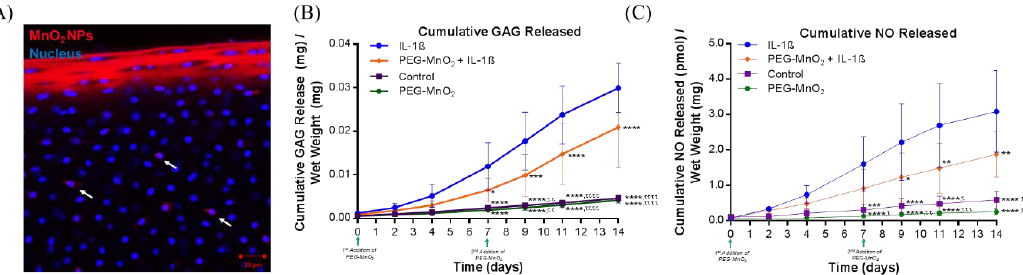
Figure 1. Characterization of MnO 2 NPs. ( A ) The TEM size of the MnO 2 NPs was 15.0 nm ( ± 4.3 nm) (scale bar = 100 nm) ( B ) The MnO 2 NPs were e ff ective in scavenging H 2 O 2 , with 5 < g / mL MnO 2 NPs neutralizing 65% of 100 < M H 2 O 2 in PBS where ** p ≤ 0.01.